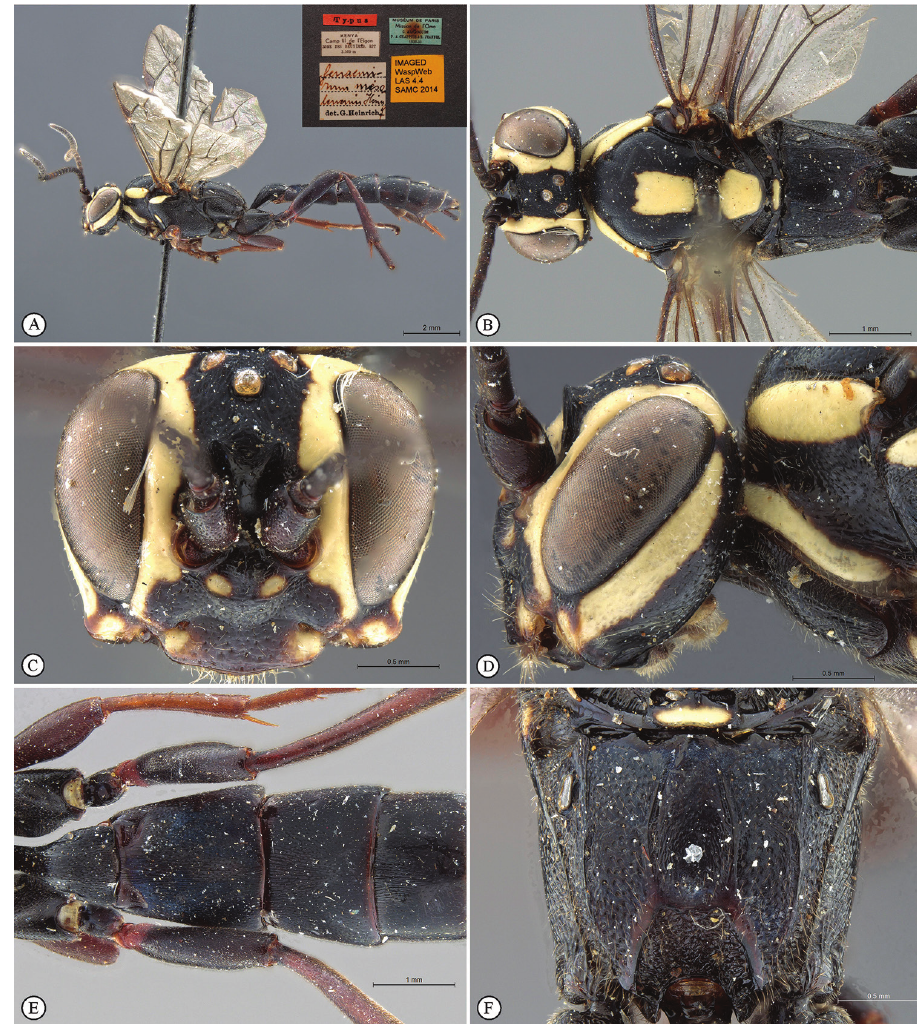
Figure 6. Genaemirum mesoleucum Heinrich. Holotype female. A habitus lateral view (inset: data labels) B head, mesosoma, dorsal view C head anterior view D head, pronotum lateral view E metasomal tergites 1-4 dorsal view F propodeum, dorsal